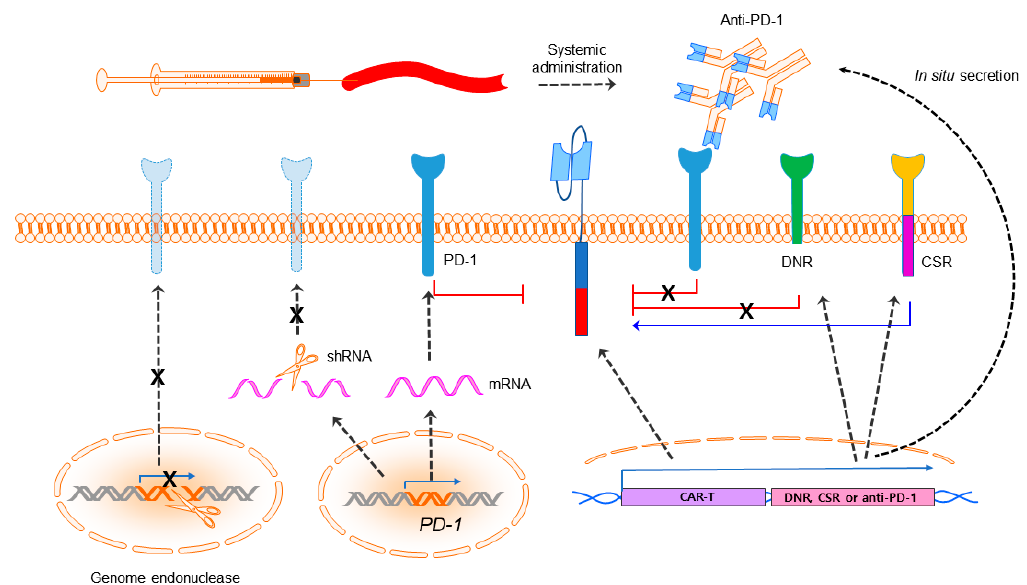
Figure 2. Immune checkpoint blockade. CAR-T cells can be augmented in efficacy with PD-1 blockade by systemic combination of anti-PD-1 or anti-PD-L1 antibodies and being engineered to secrete anti-PD-1/PD-L1 by CAR-T cells or express a PD-1 dominant negative receptor (DNR) or a PD-1:CD28 chimeric switch-receptor (CSR). Expression of PD-1 also can be downregulated by a PD-1 shRNA lentiviral cassette or PD-1 deficient CAR-T can be generated utilizing programmable genome editing endonucleases. The black dashed arrow indicates expression of the genes unless specified. The signs “X” denotes steps prohibited.